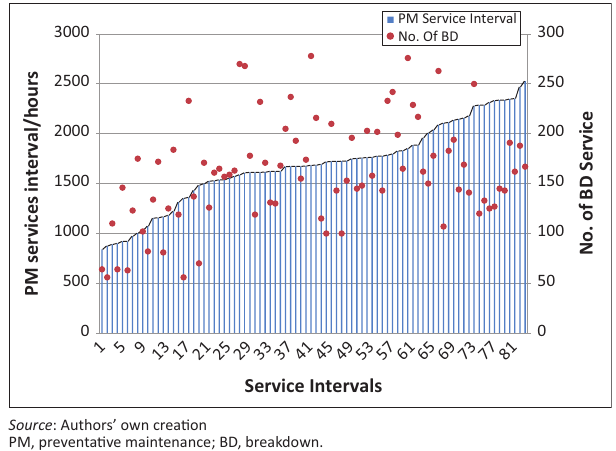
FIGURE 4: Breakdown against preventative maintenance service intervals.